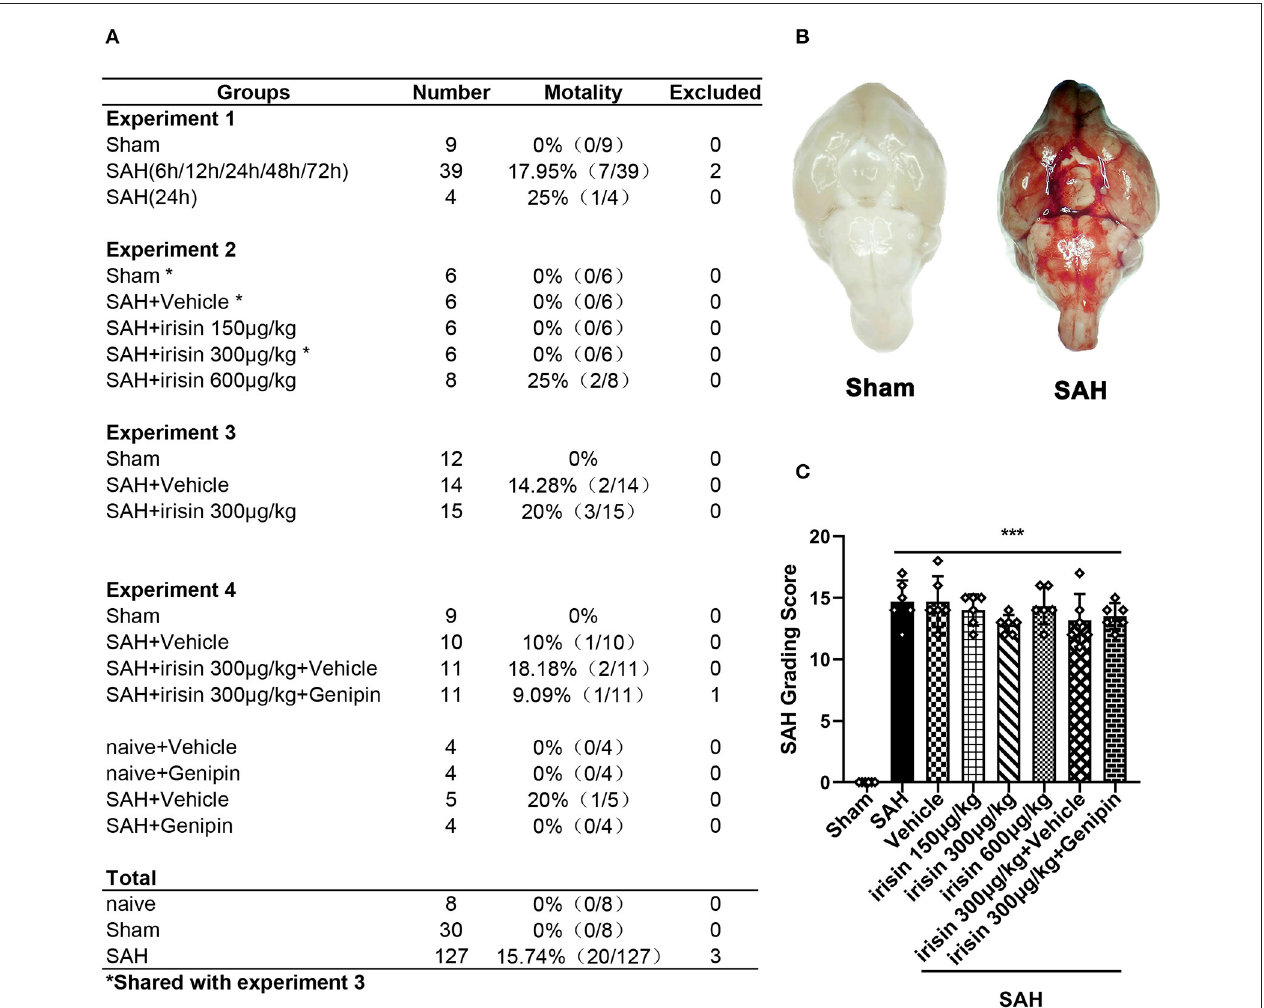
FIGURE 1 | Animal usage and SAH grade. (A) The record of the animal used in this experiment. (B) Representative pictures of brains in the sham and SAH groups. (C) SAH grade scores in each group. Data were represented with mean ± SD, n = 6 per group; the one-way ANOVA was used followed by the Tukey’s HSD post-hoc test and the Holm–Bonferroni correction method. *** P < 0.001 vs. sham group. Vehicle group, sterile 0.9% of NaCl; SAH, subarachnoid